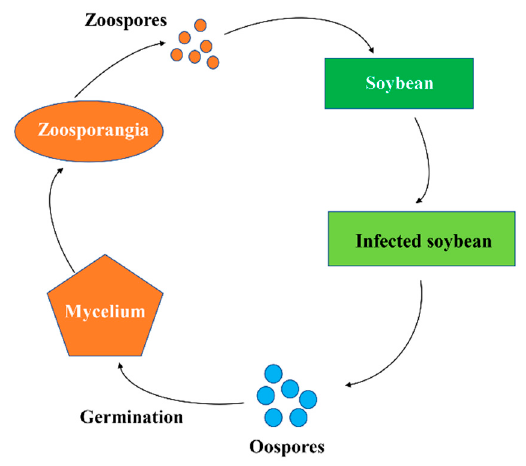
Figure 2. Infection cycle of Phytophthora sojae